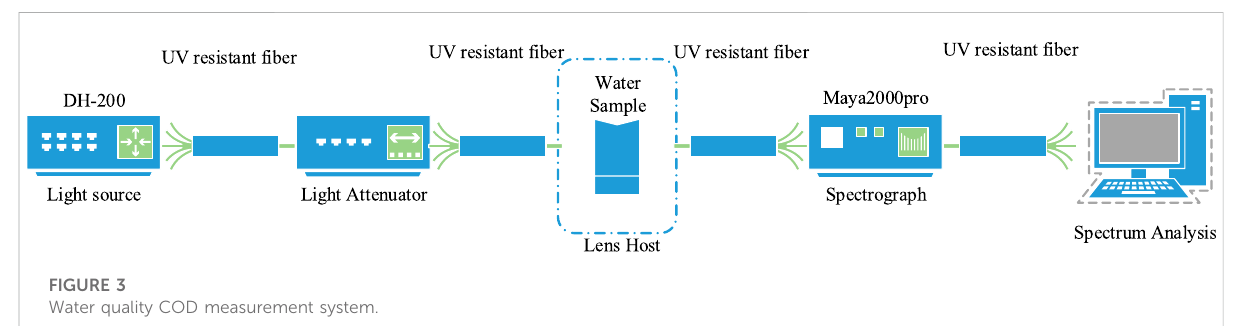
FIGURE 3 Water quality COD measurement